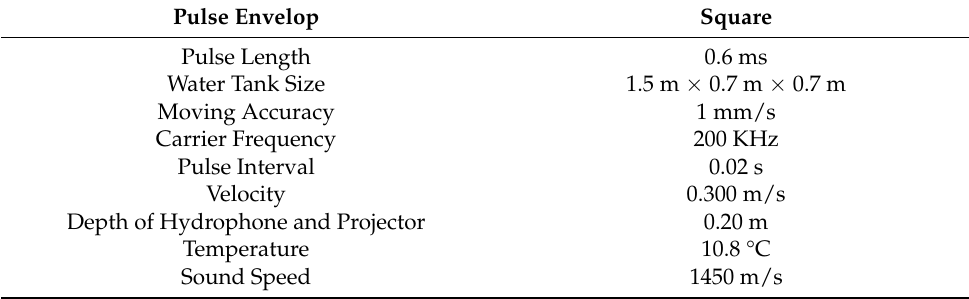
Table 2. Equipment parameters.